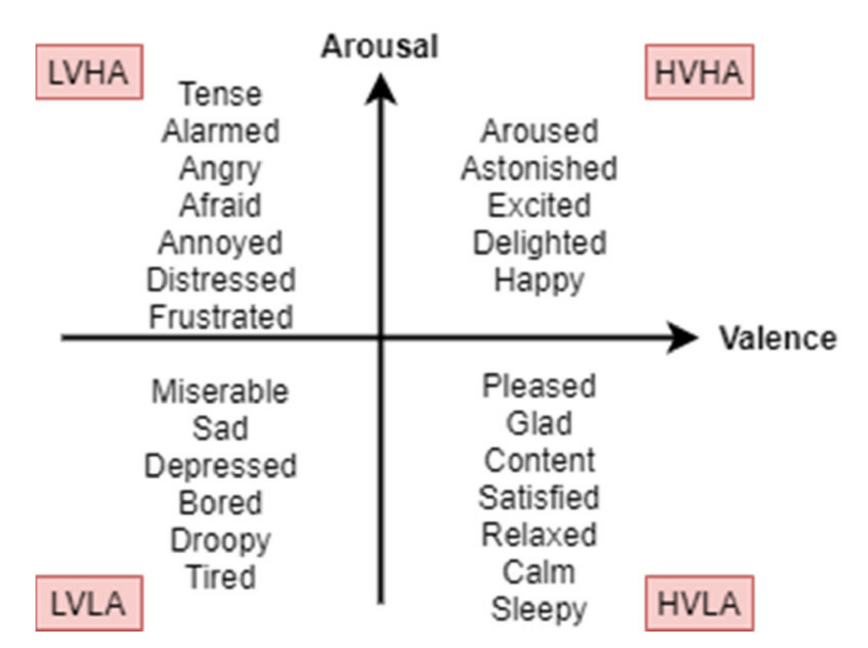
Figure 6. The mapping function between the ADM and DEM